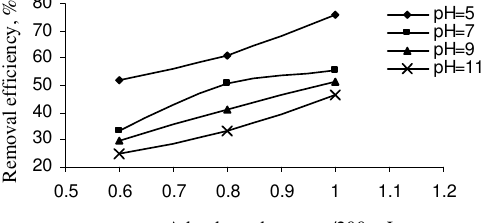
Figure 3. Effect of adsorbent dosage on dye removal in different pH (contact time =1 h, dye solution of 50